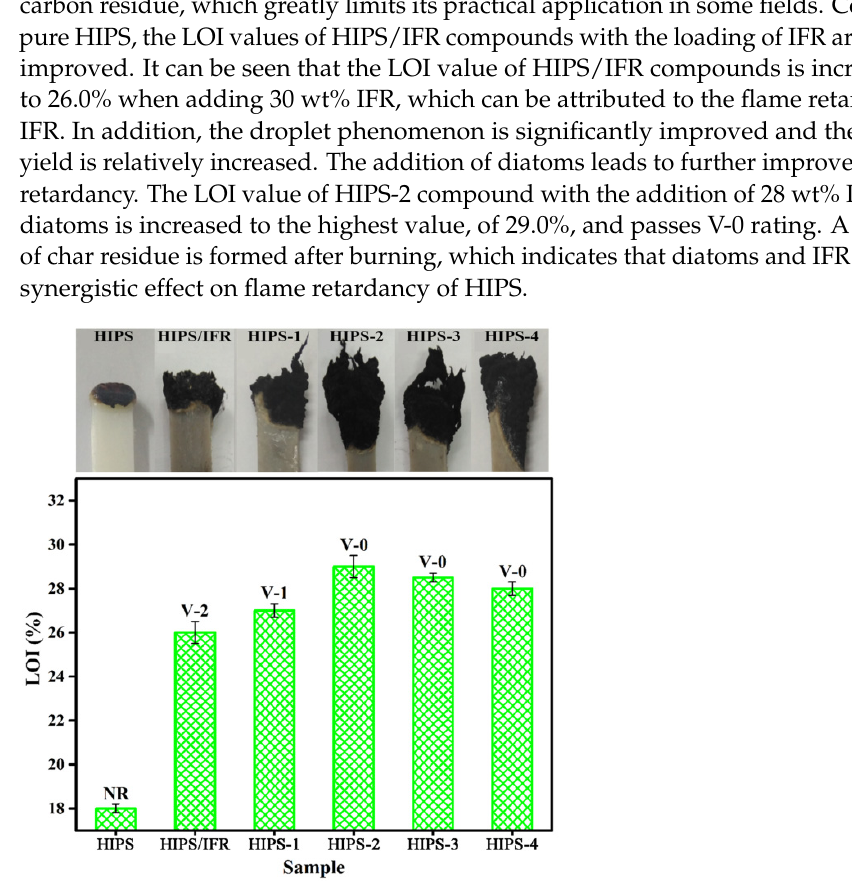
Figure 5. The digital photos after LOI tests, the LOI and UL-94 results of the HIPS